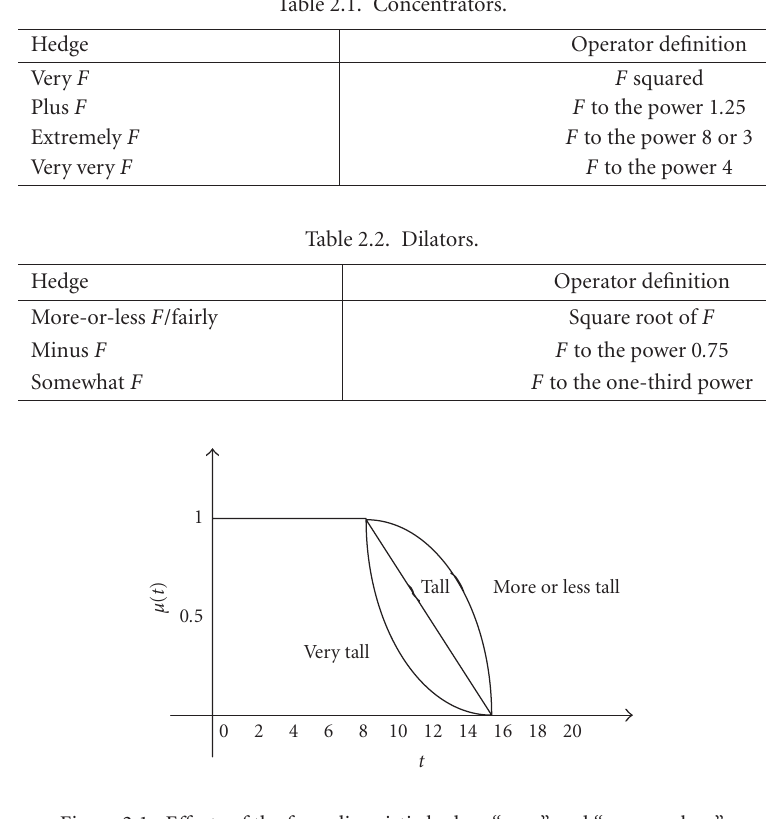
Figure 2.1. E ff ects of the fuzzy linguistic hedges “very” and “more or